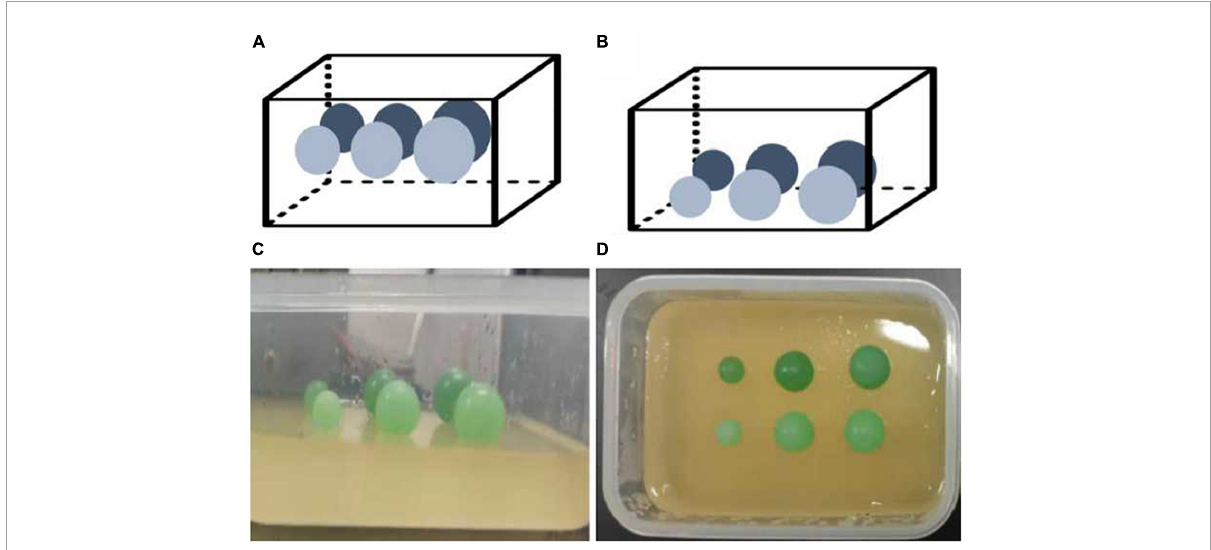
FIGURE1 Elastic tissue-mimicking phantoms. The schematic and pictures show the phantoms with subjects within the different sizes, depths, and stiffnesses in the matrix. (A) Phantom 1; (B) Phantom 2; (C,D) gelatin